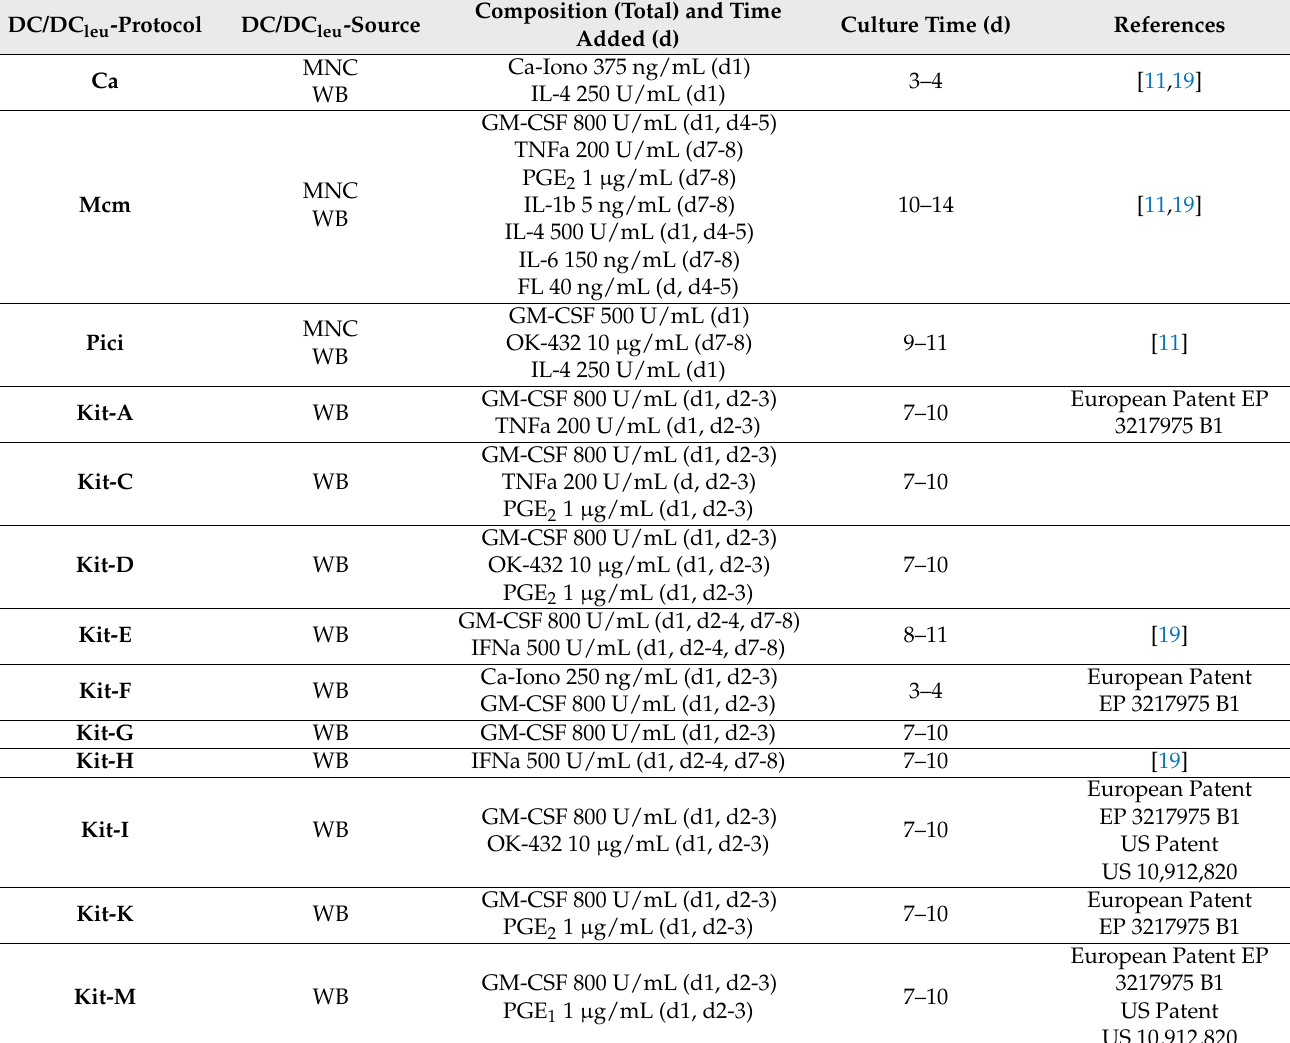
Table 8. DC/DC leu -generating